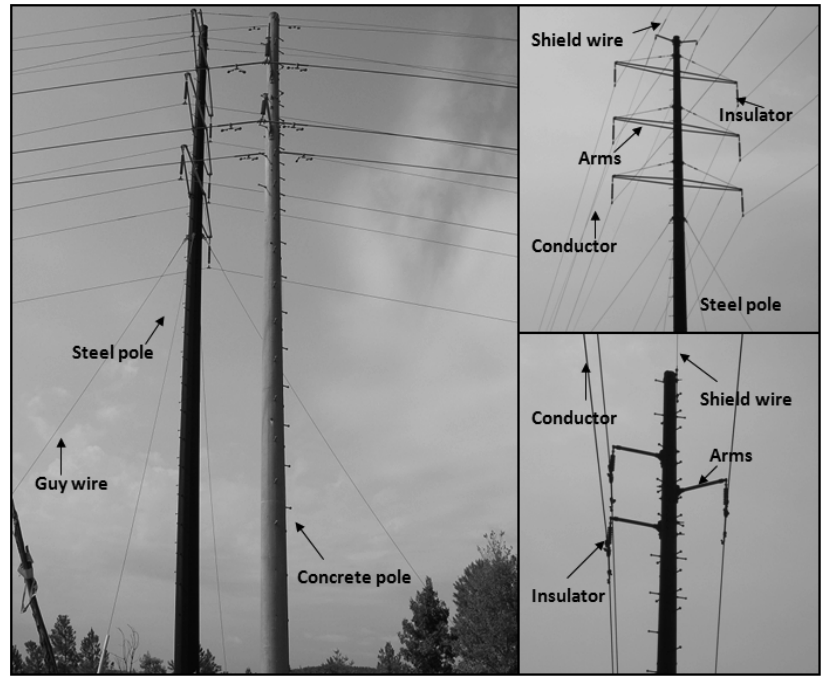
Fig. 1. Two operational transmission lines